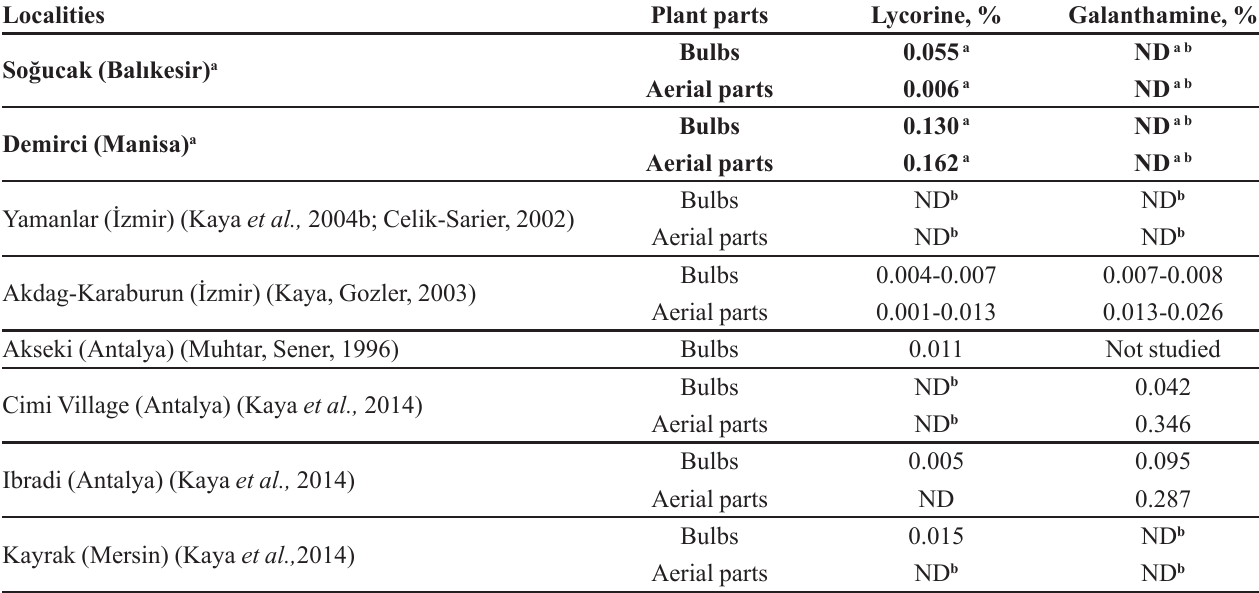
TABLE III - Lycorine and galanthamine content of Galanthus elwesii from different localities